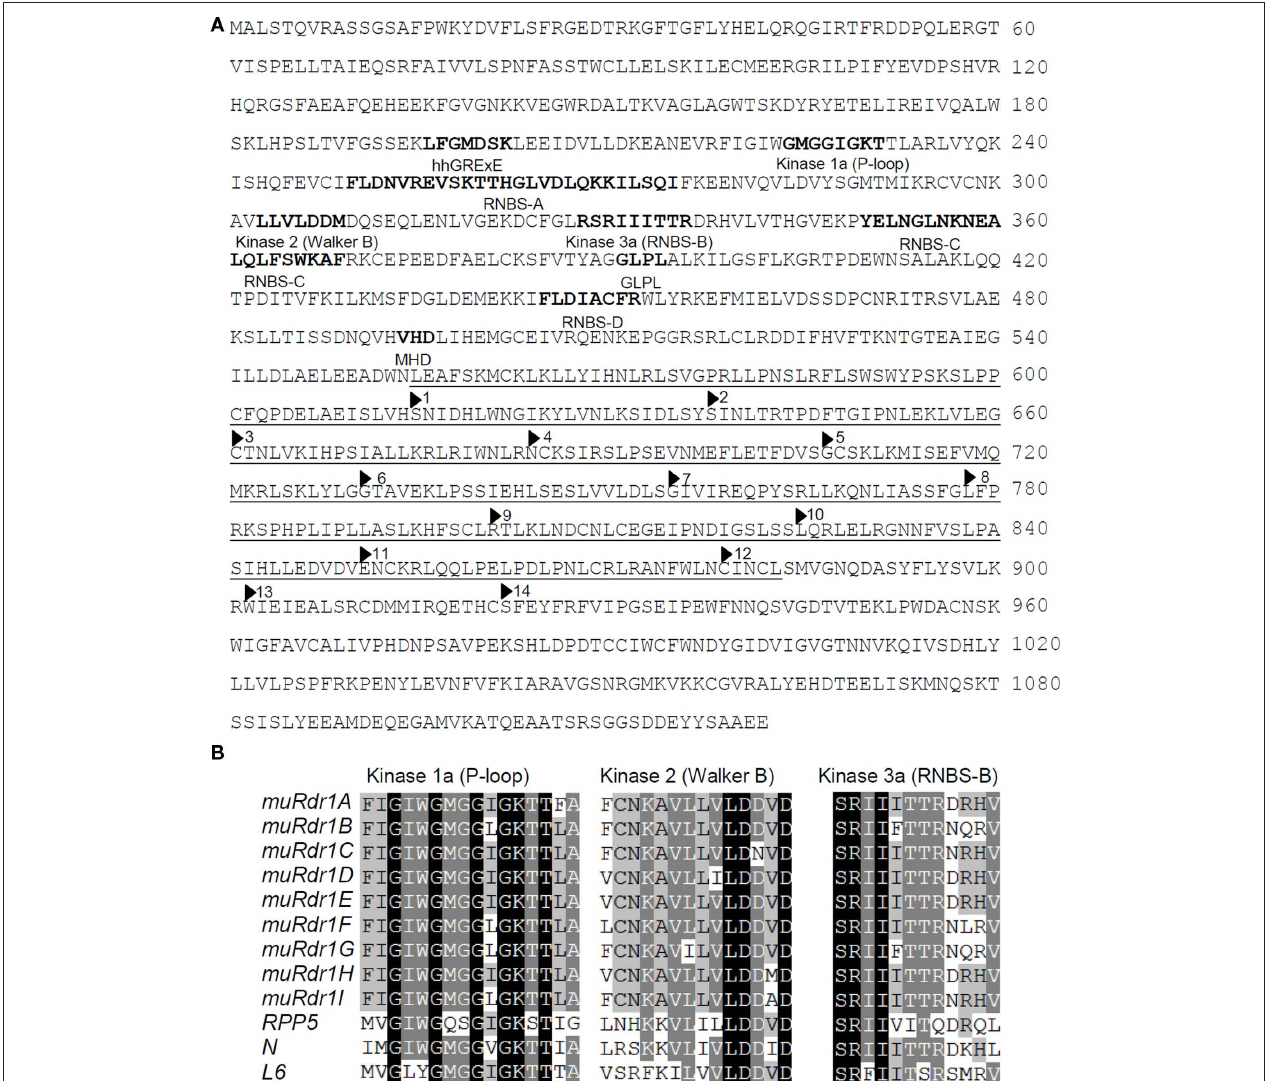
Figure 3 | The muRdr1 protein sequence and conserved motifs. (A) muRdr1H protein sequence. Conserved motifs are indicated as bold letters and the 14 imperfect leucine-rich repeats (LRRs) are underlined. (B) Alignments of kinase